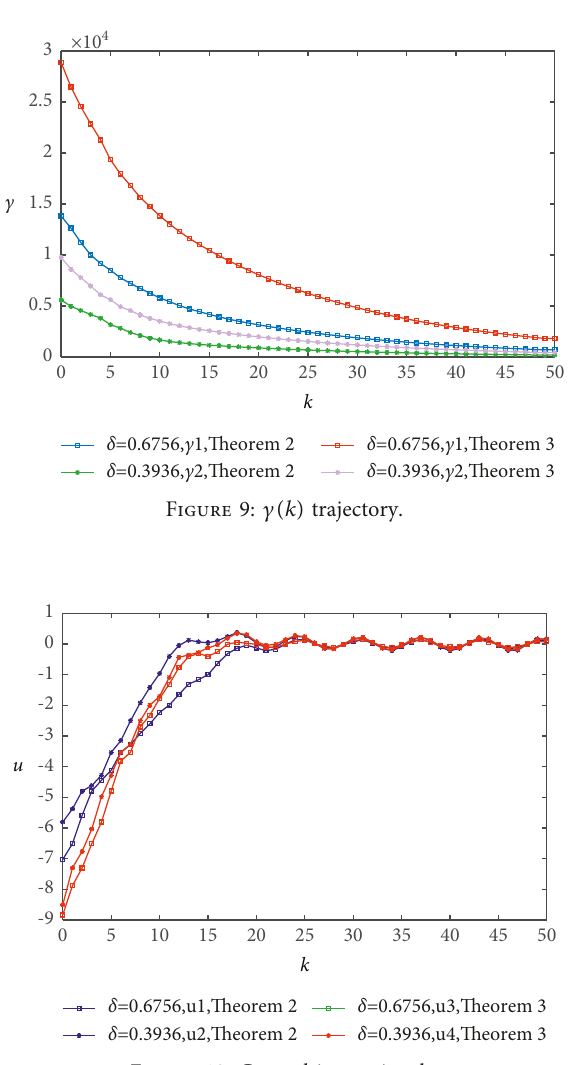
Figure 10: Control input signals.